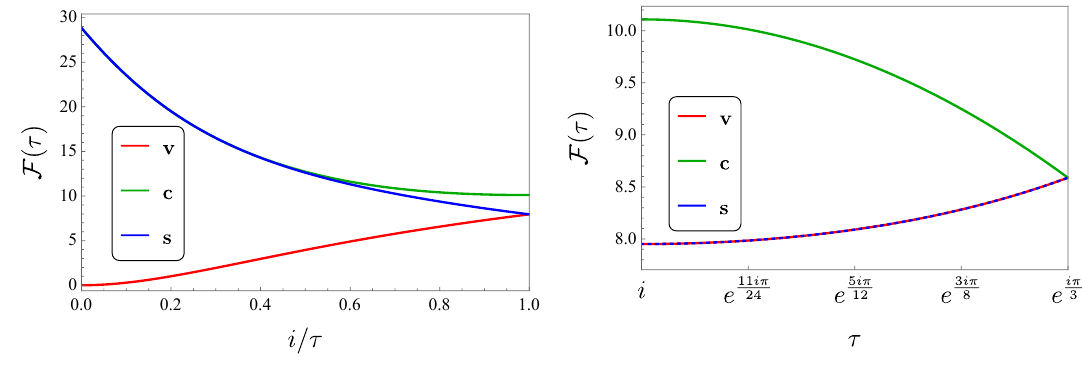
Figure 2 . The localization inputs for F v , F c , and F s as a function of i/τ from the free point τ = i ∞ until the S -duality invariant point τ = i with < ( τ ) = 0 ( left ), and as a function of τ along the S -duality invariant arc with | τ | = 1 from τ = i to the T -duality invariant point τ = e πi/ 3 ( right ). Note that the triality related localization inputs in different duality fundamental domains are related as in